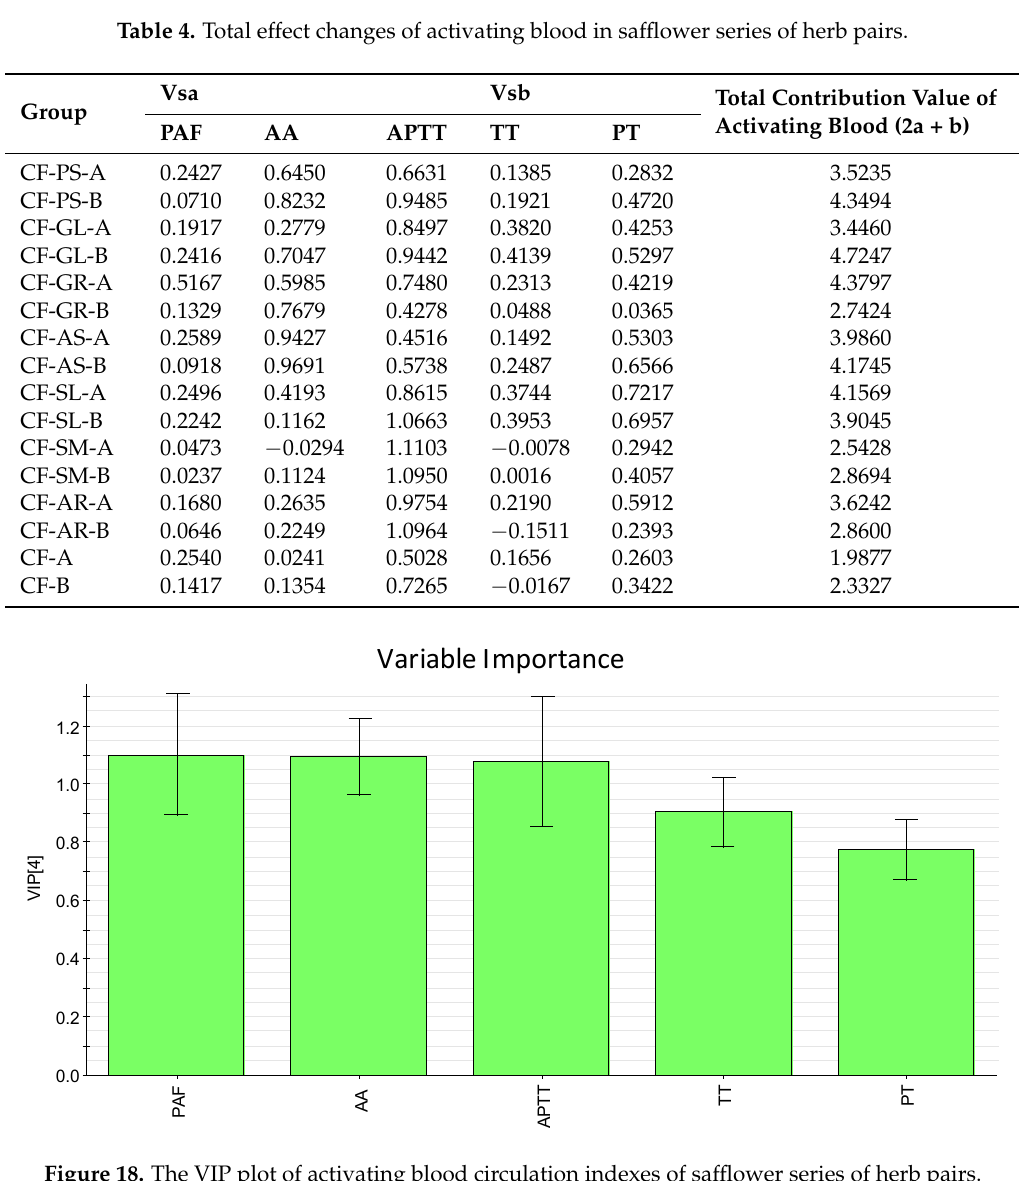
Figure 18. The VIP plot of activating blood circulation indexes of safflower series of herb pairs. Table 4. Total effect changes of activating blood in safflower series of herb pairs.